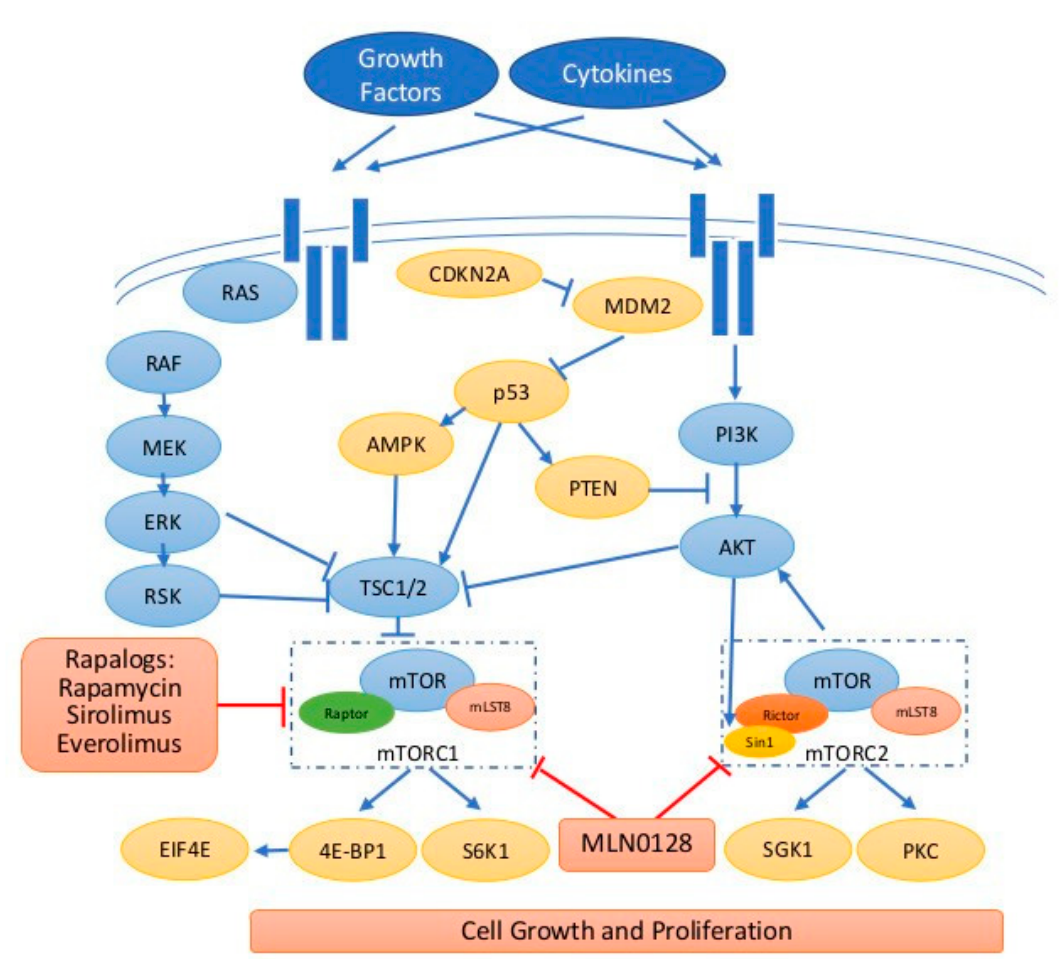
Figure 1. The signaling transduction of mTOR pathway. Extracellular signals such as growth factors and cytokines binding to the receptors stimulate RAS/RAF/MEK/ERK and PI3K/AKT/mTOR caspases. mTOR exists in two functionally and structurally distinct complexes, mTORC1 and mTORC2. Both mTORC1/2 contain different core components so they phosphorylate a distinct set of substrates and exhibit distinct function. PTEN is a negative regulator for PI3K/AKT. In addition, ERK/RSK, AMPK, and p53 regulate mTORC1 through TSC2 regulation. Rapalogs mainly inhibit mTORC1 and new-generation mTOR inhibitors such as MLN0128 inhibitor both mTORC1/2. Blue t-bar indicates inhibition, blue arrow indicates stimulation/activation, red t-bar indicates inhibition by drugs, and dashed square indicates mTOR1/2 complexes.